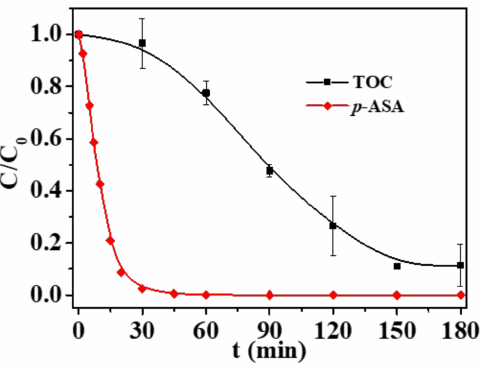
Figure 2. Changes of total organic carbon (TOC) with the degradation of p -ASA. Conditions: ( p